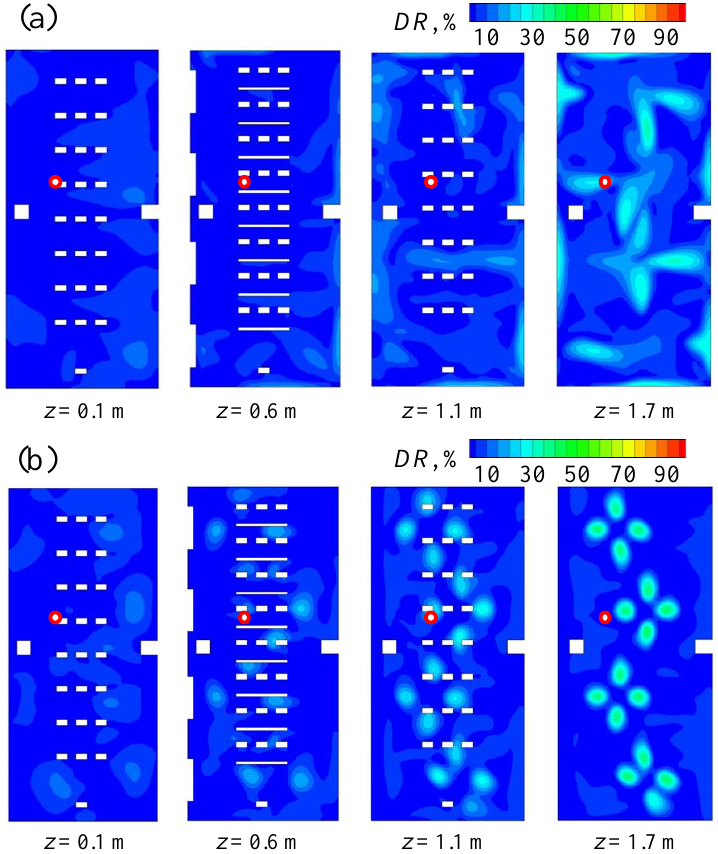
Figure 8. RANS-computed fields of draught rate ( DR ) at four cross-sections of the room for two cases: ( a ) θ = 25 ◦ and ( b ) θ = 45 ◦ ; red circles indicate the A-A vertical line position.